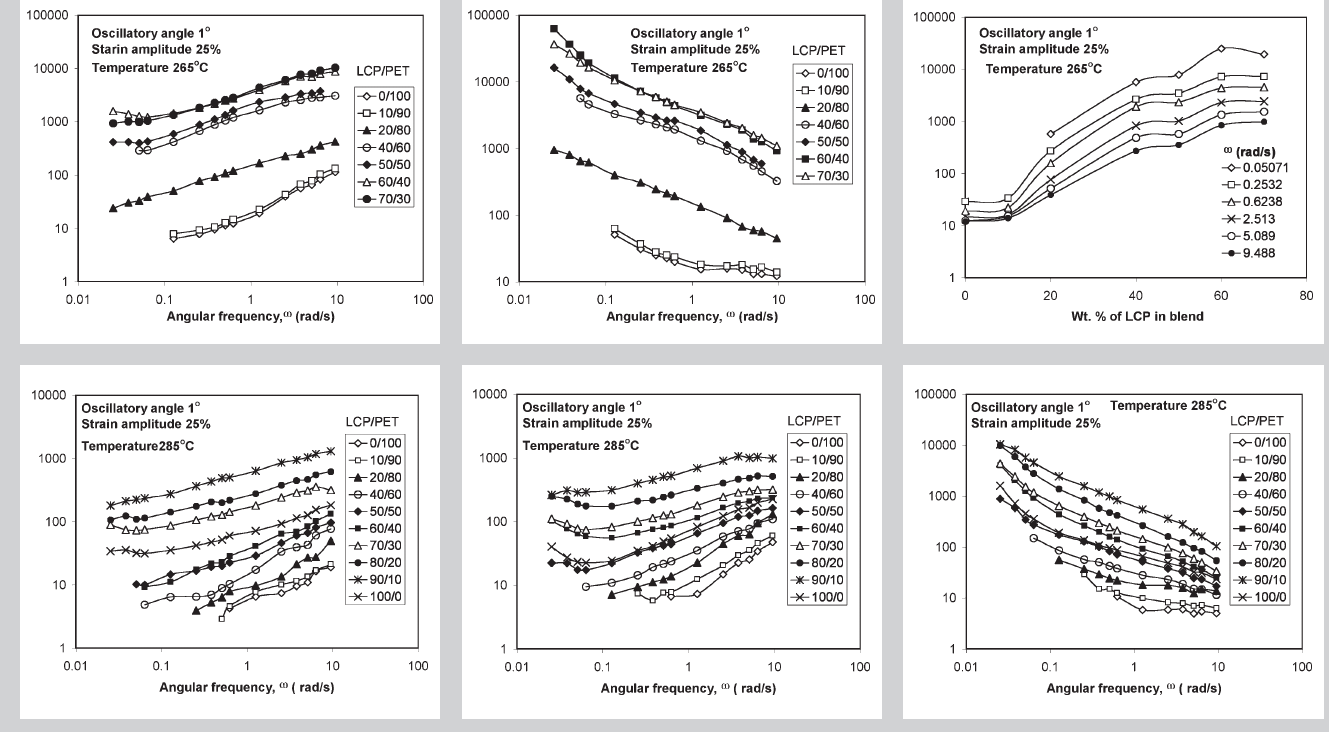
Figure 4 (left above): Complex modulus, G* and angular frequency, w , at 265°C for different LCP/PET blends. Figure 5 (middle above): Complex viscosity, h * and angular frequency, w , at 265°C for different LCP/PET blends. Figure 6 (right above): Dynamic viscosity and the composition of blend at 265°C corresponding to dif- ferent shear rates. Figure 7 (left below): Storage modulus, G’ and angular frequency, w , at 285°C for different LCP/PET blends. Figure 8 (middle below): Loss modulus, G’’ and angu- lar frequency, w , at 285°C for different LCP/PET blends. Figure 9 (right below): Dynamic viscosity, h ’ and angular frequency, w , at 285°C for different LCP/PET